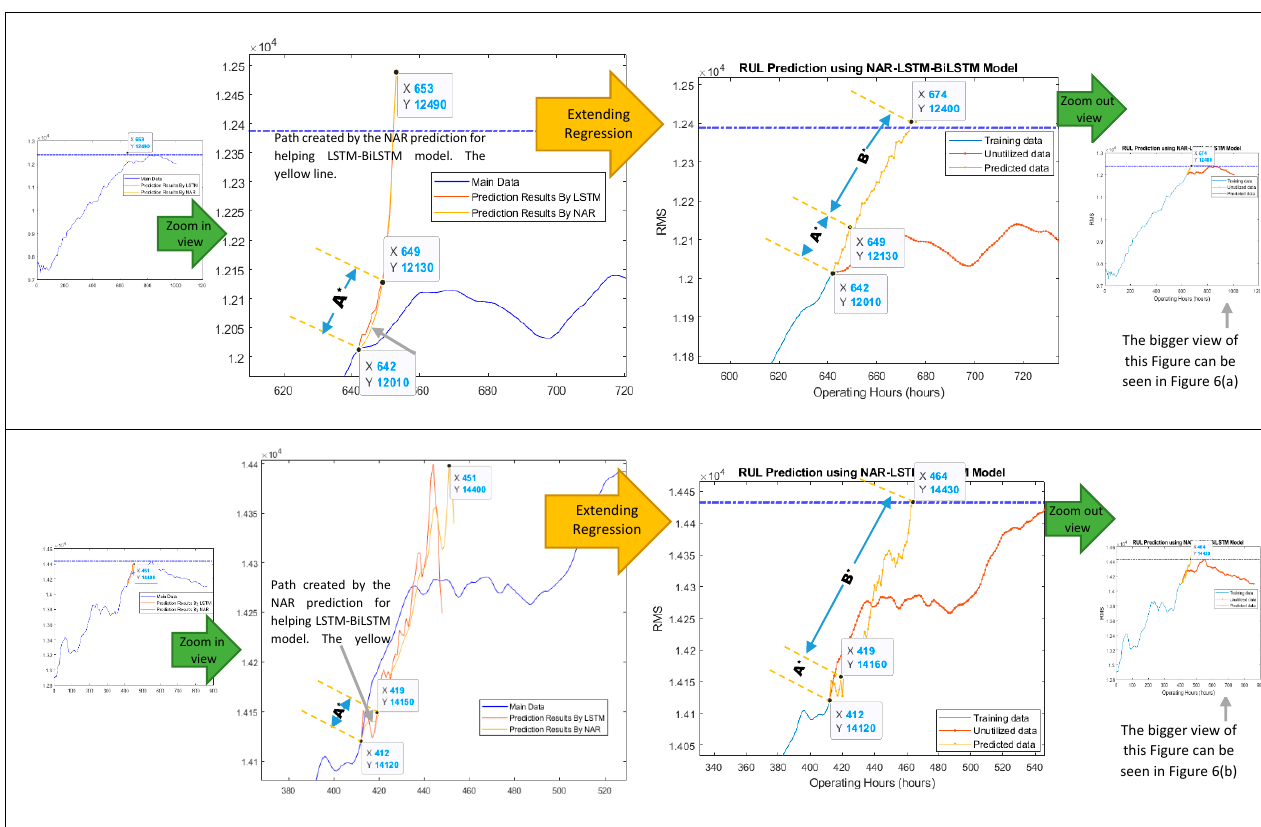
Figure 8. Explaining the RUL prediction philosophy by the hybrid NAR-LSTM-BiLSTM model for ( a ) datasets collected in 2014, and ( b ) datasets collected in 2017 for overall RUL prediction. A* = Initial LSTM-BiLSTM prediction points, which were obtained by following the path created by the NAR model. Actually, the path created by the NAR model is the prediction made by the NAR model. B* = Extending the A* for obtaining the overall RUL by utilizing the LSTM-BiLSTM